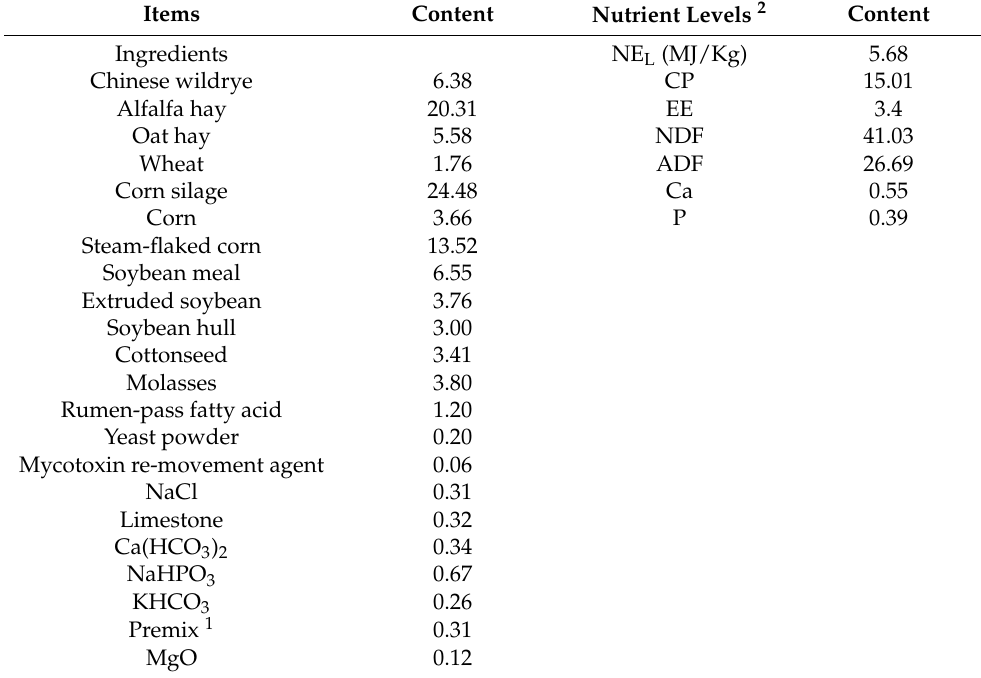
Table 2. Composition and nutrient value of basic diet (DM basis